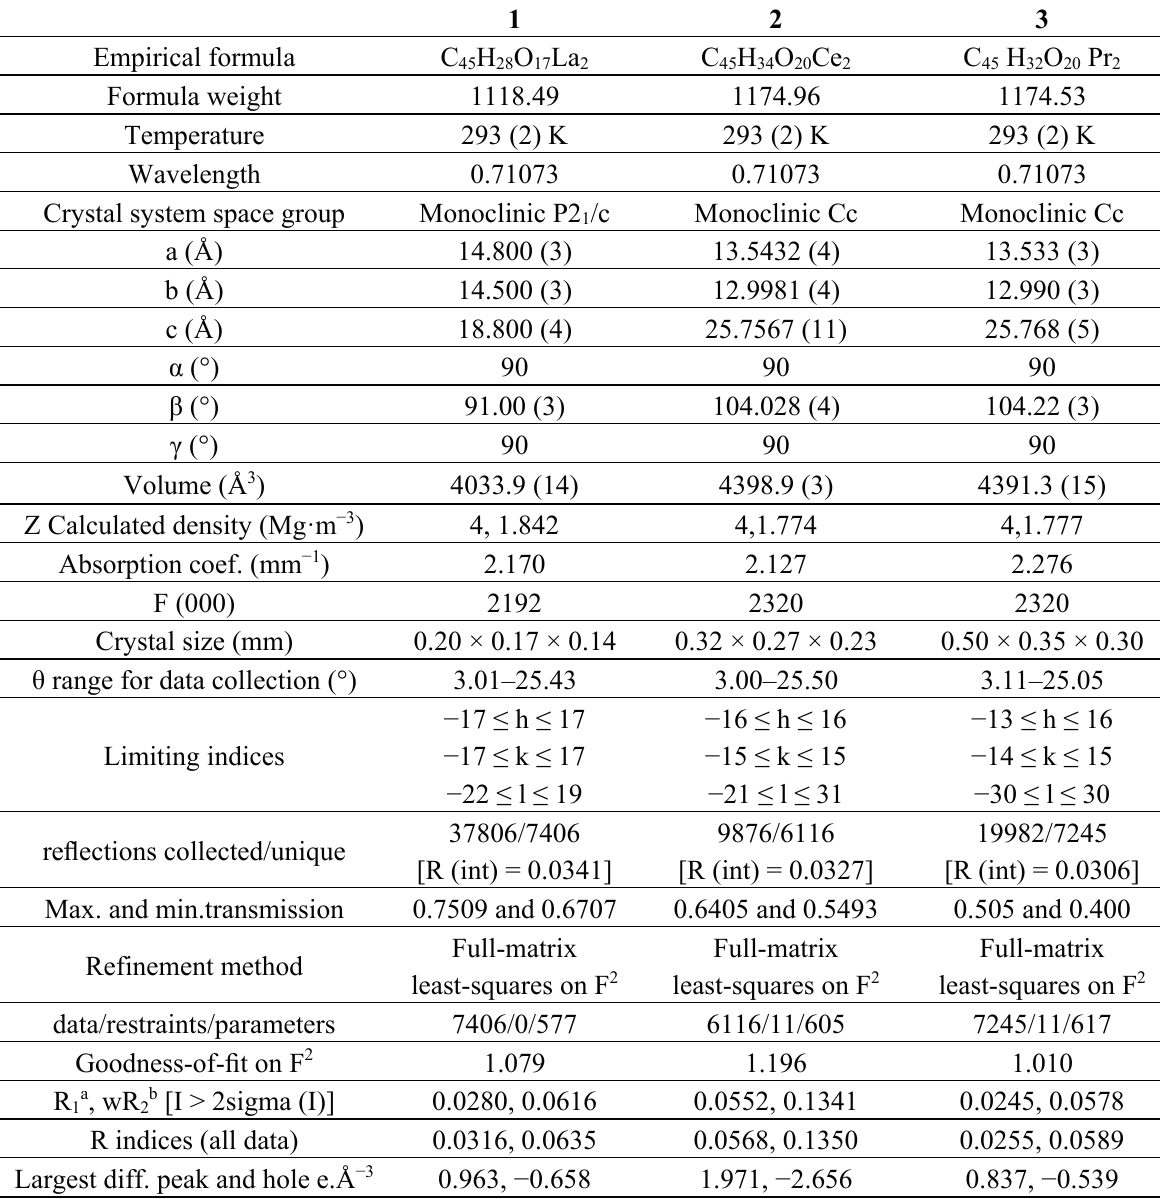
Table 1. Crystal data and structure refinement parameters for complexes 1 – 3